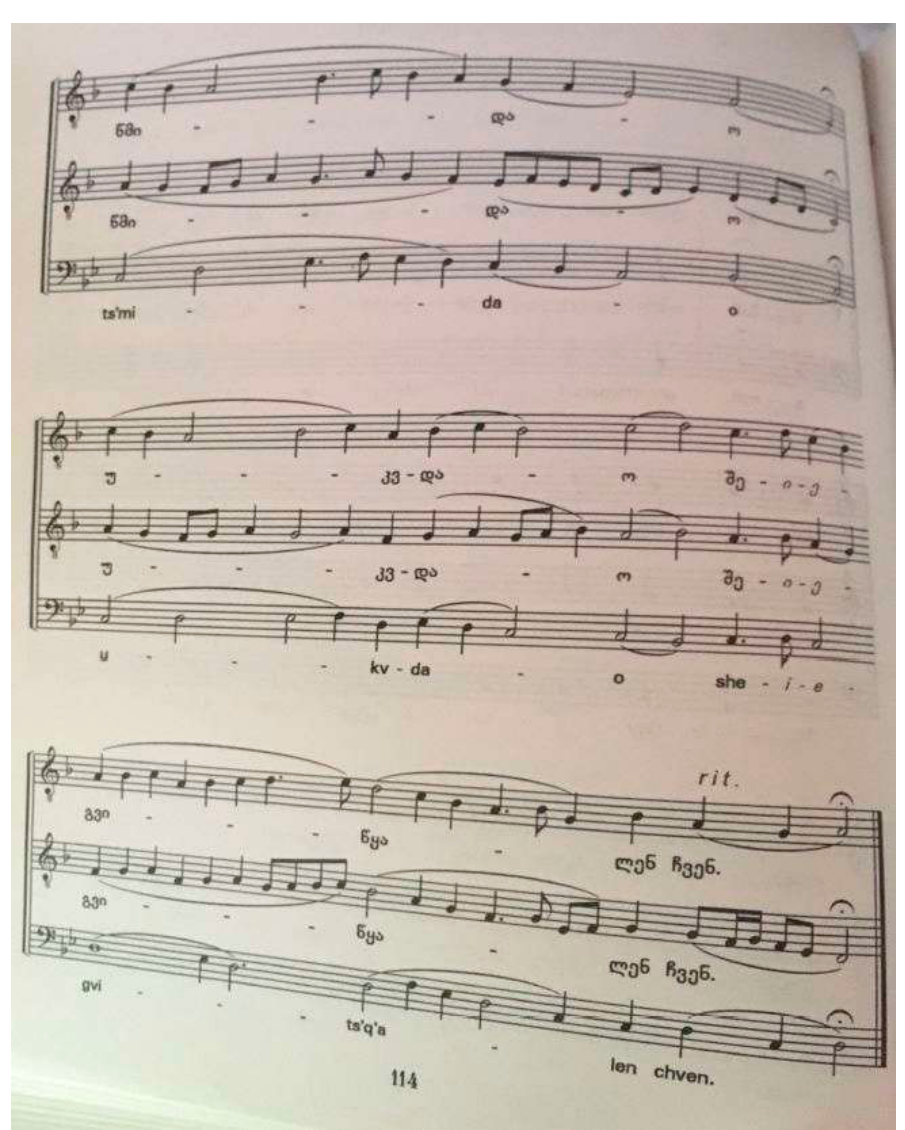
Figure 11. Trisagion; Gelati School (Chkhikvishvili and Razmadze 2010).